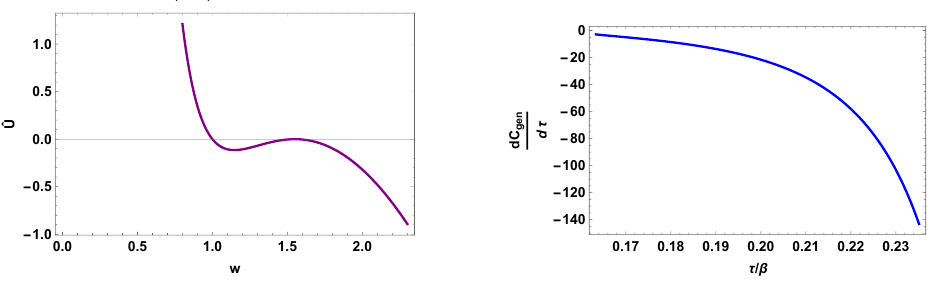
Figure 17 . The case d = 2 , θ = 0 , z = 1 and λ = − 0 . 2 : Left ) The effective potential as a function of w . For this value of λ there is just one maximum w The growth rate d C gen